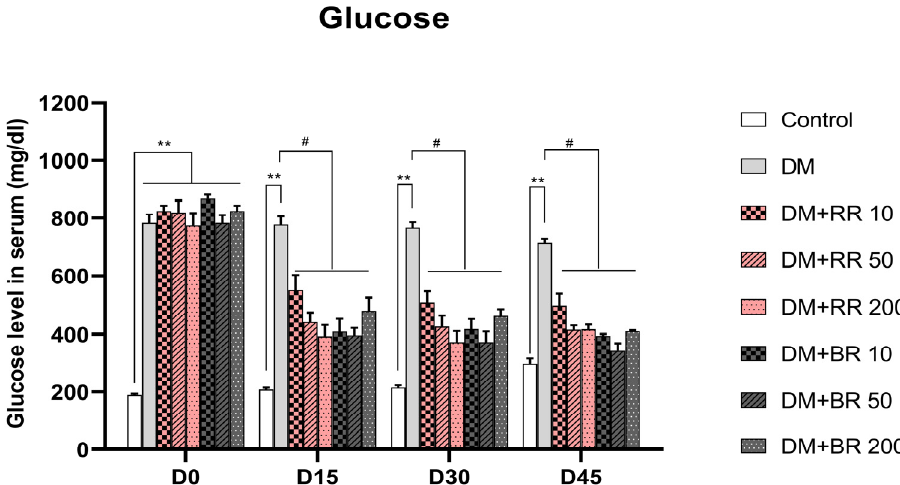
Figure 1. Effects of various doses of RR and BR on blood glucose levels in STZ-induced diabetic rats. ** p < 0.01, diabetic control group vs. healthy control group; # p < 0.05, treated group vs. diabetic control. Values represent mean ± S.E.M. (n = 8) .